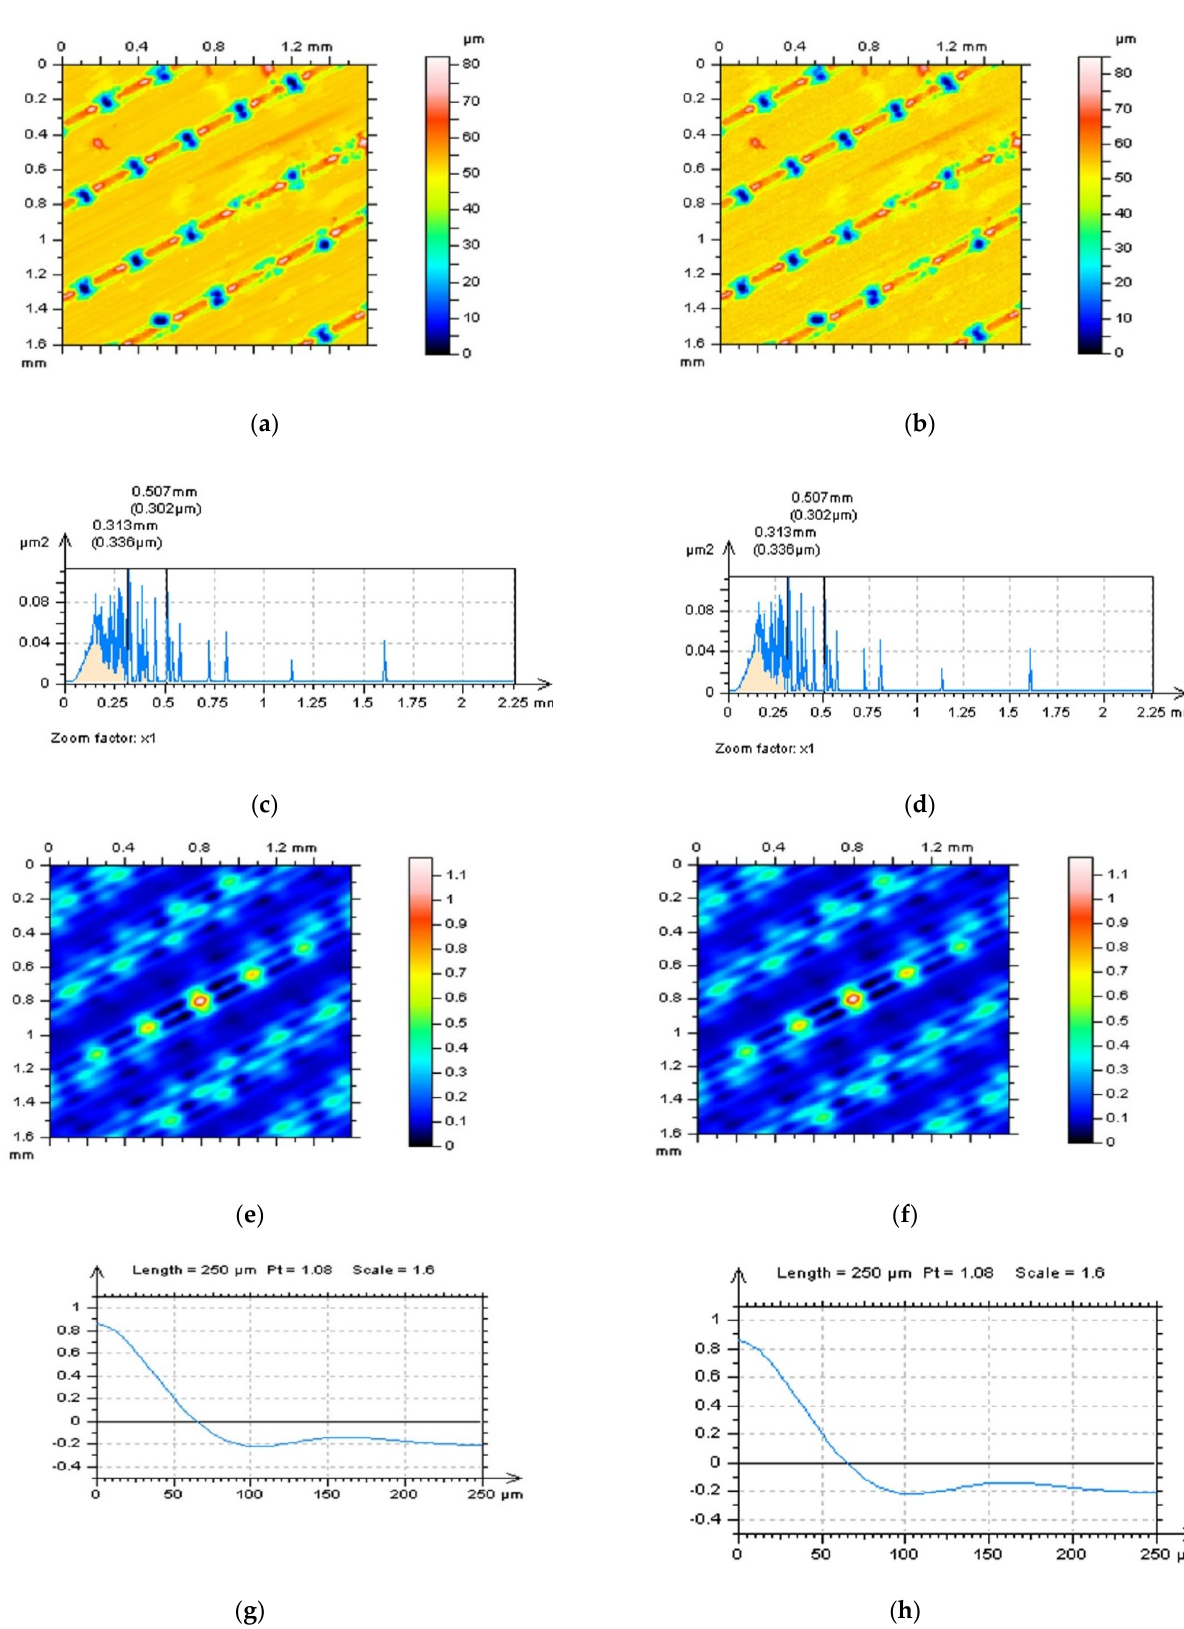
Figure 2. Laser-textured surface topography: contour map plots ( a , b ); their PSDs ( c , d ); ACFs ( e , f ); and centre-extracted ACF profiles ( g , h ); measured ( left column) and containing a high-frequency measurement noise ( right column).